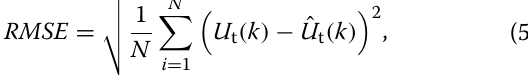
structure. For example, R(RQ)W represents a model which consists of a resistance R , a R//CPE parallel branch and a Warburg element connected in series. The voltage U c across a R//CPE branch and U w across